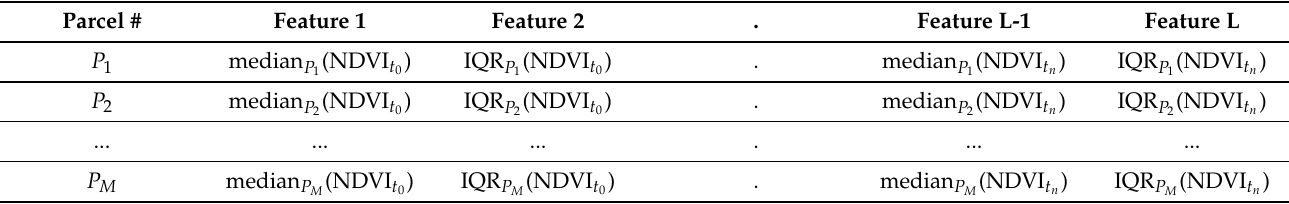
Table 3. Simplified version of the feature matrix using NDVI only and two statistics (median/IQR) for n dates and M parcels. NDVI t means NDVI computed for image # n and median P n the parcel # M